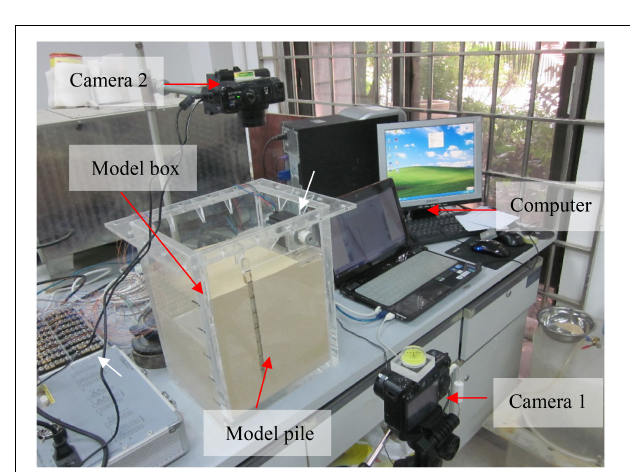
FIGURE 3 | Schematic diagram showing setup for slicing transparent synthetic soils.